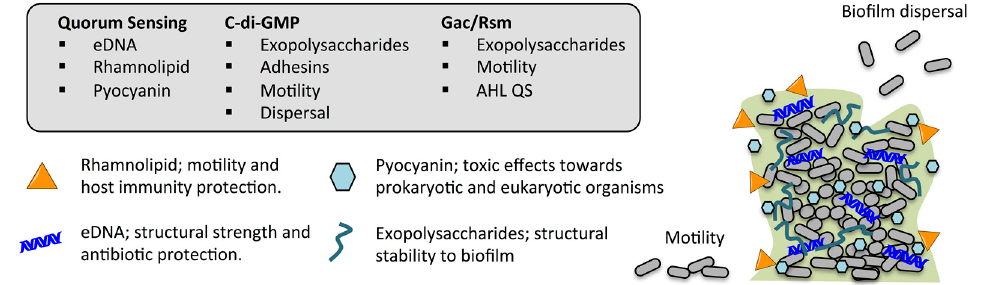
Figure 2. Inter-cellular regulatory systems involved in P. aerugionsa biofilm life-cycle; quorum sensing, c-di-GMP and Gac/Rsm cascade with examples of essential factors being produced under the control of these particular systems. AHL: N -acyl- L -homoserine lactone; QS: quorum sensing.